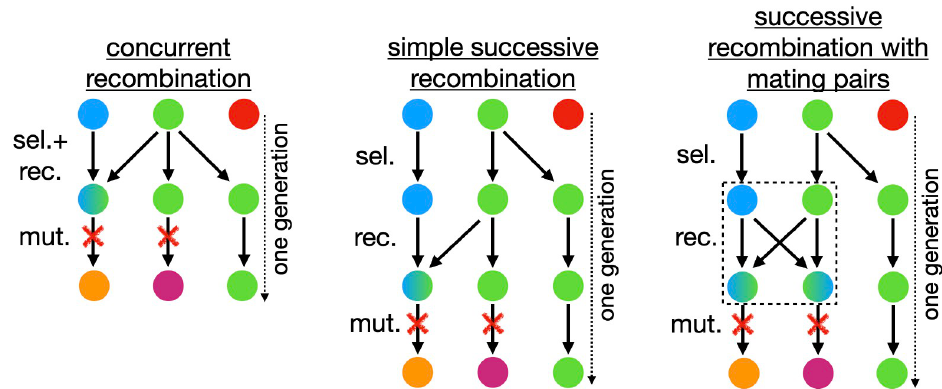
Fig 1. One generation of evolution in the three slightly different selection-recombination-mutation schemes. Nodes represent individuals and colors genotypes, with green and blue nodes being viable and red nodes unfit. The arrows show the lineages from the ancestors to the descendants. Individuals with two incoming arrows are the product of uniform recombination. In successive recombination with mating pairs the recombining individuals are grouped in pairs and each pair creates two descendants, which is indicated by the dashed box. Mutations are indicated by red